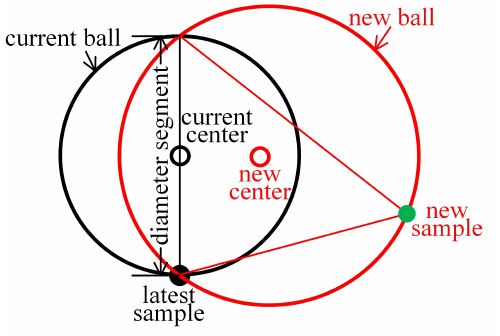
Figure 3. Basic idea of